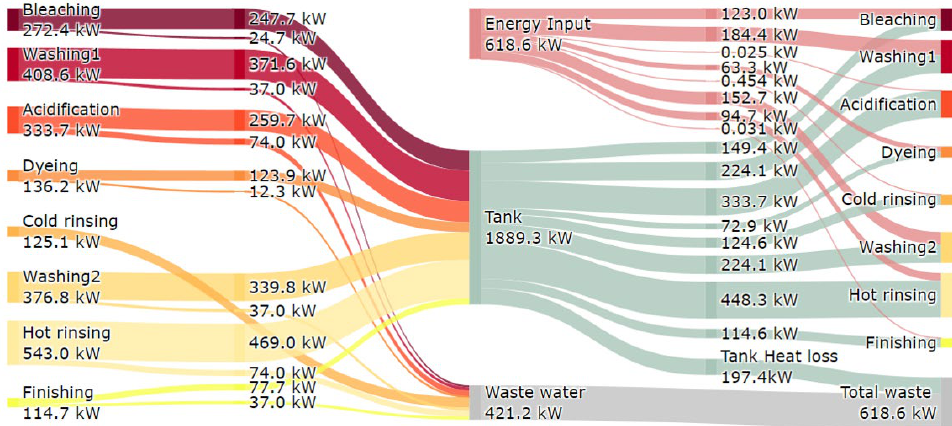
Figure 5. Effect of temperature on heat demand and drainage in Case 2.